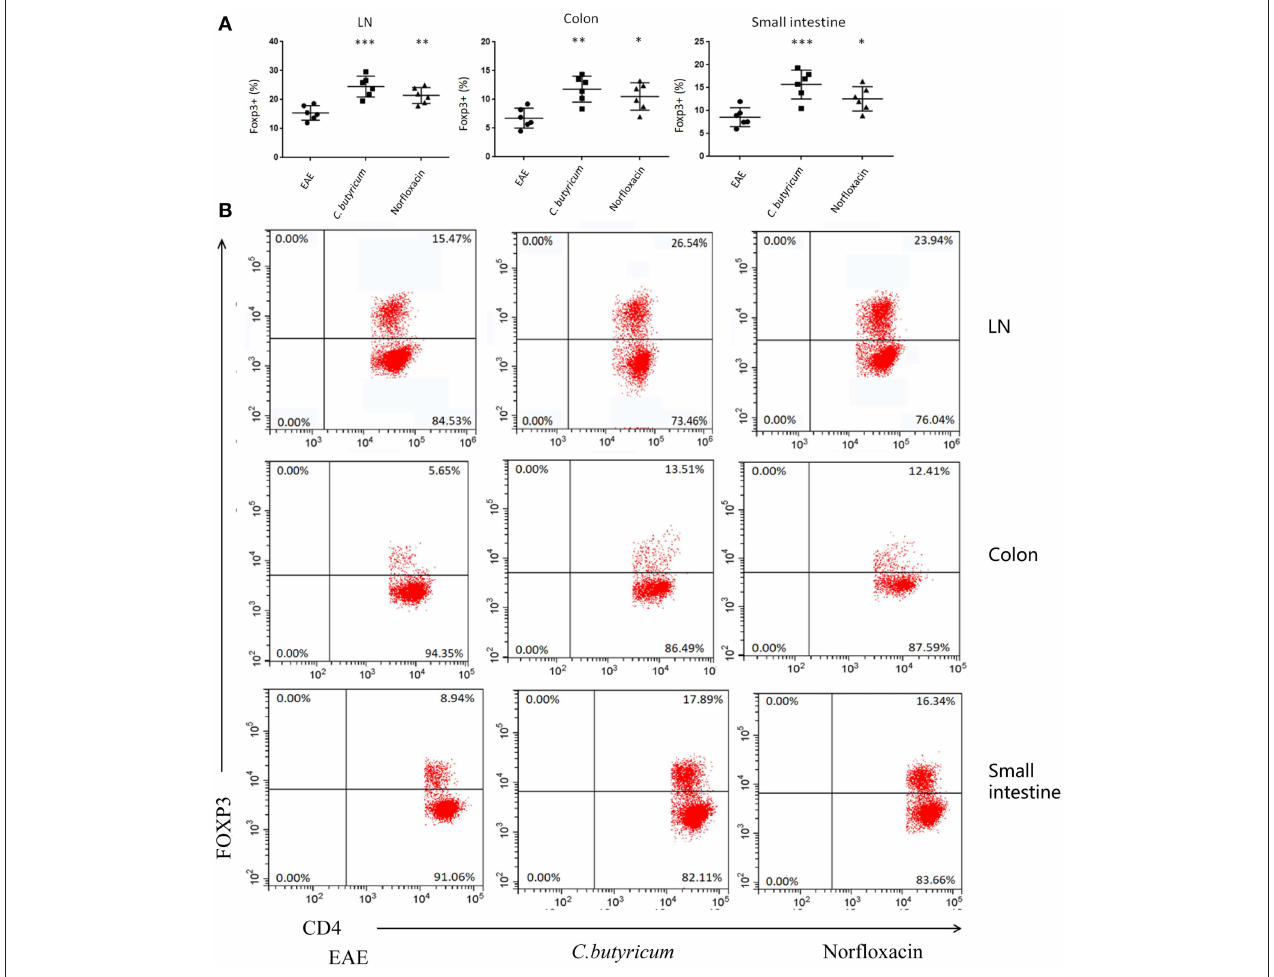
FIGURE 5 | Gut microbiota intervention expanded the Treg cells in EAE. (B) Representative staining of different CD4T cell subsets in inguinal LN, colon and small intestine, gated on TCR β + CD4 + . Statistical analysis of data in (A) . Statistically significant data are indicated by asterisks (* P < 0.05, ** P < 0.01, and *** P < 0.001).